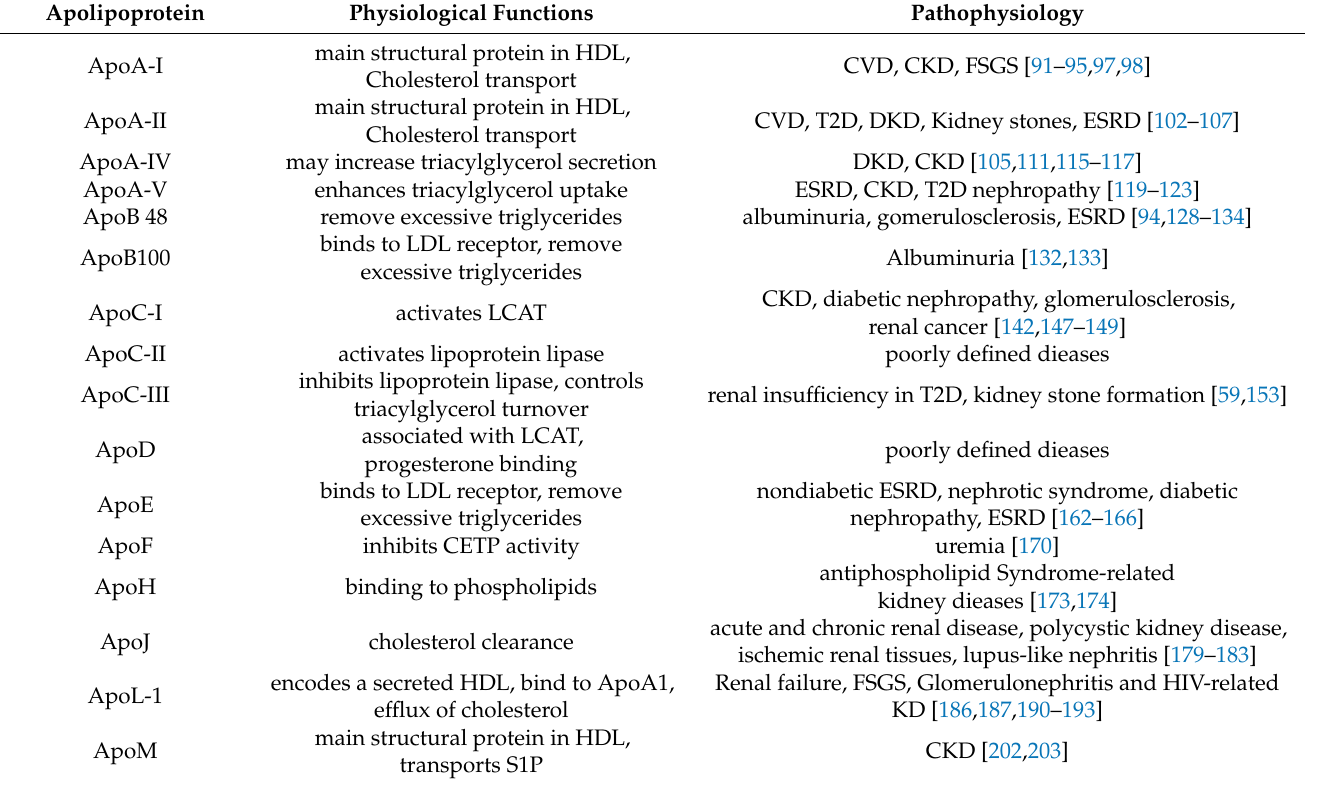
Table 2. The physiology and pathophysiology roles of apolipoproteins in the